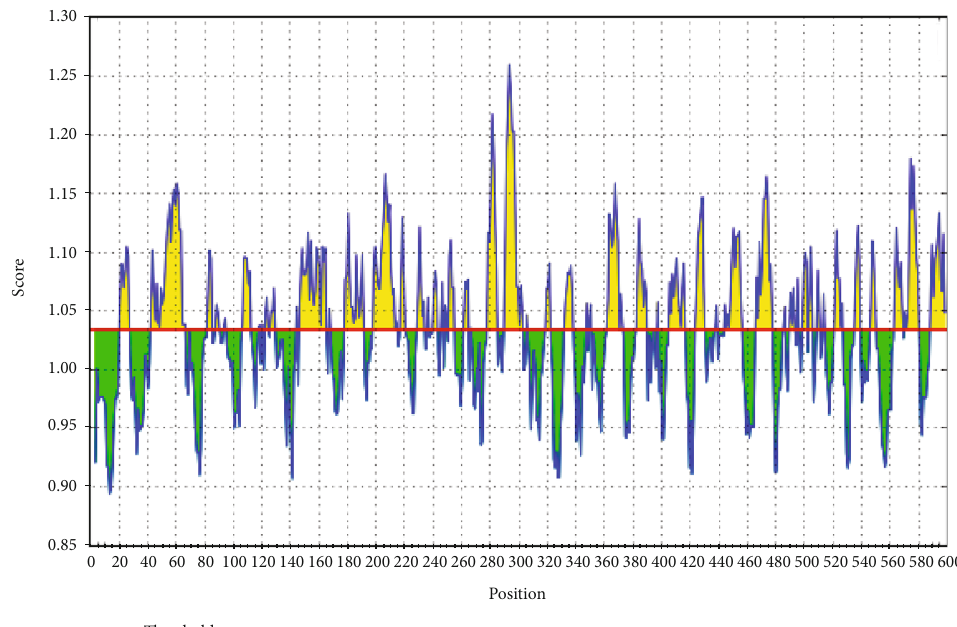
Figure 1: BepiPred linear prediction. Areas above the red line (threshold) are epitopes suggested to be binding to the B cells while the green areas are not.